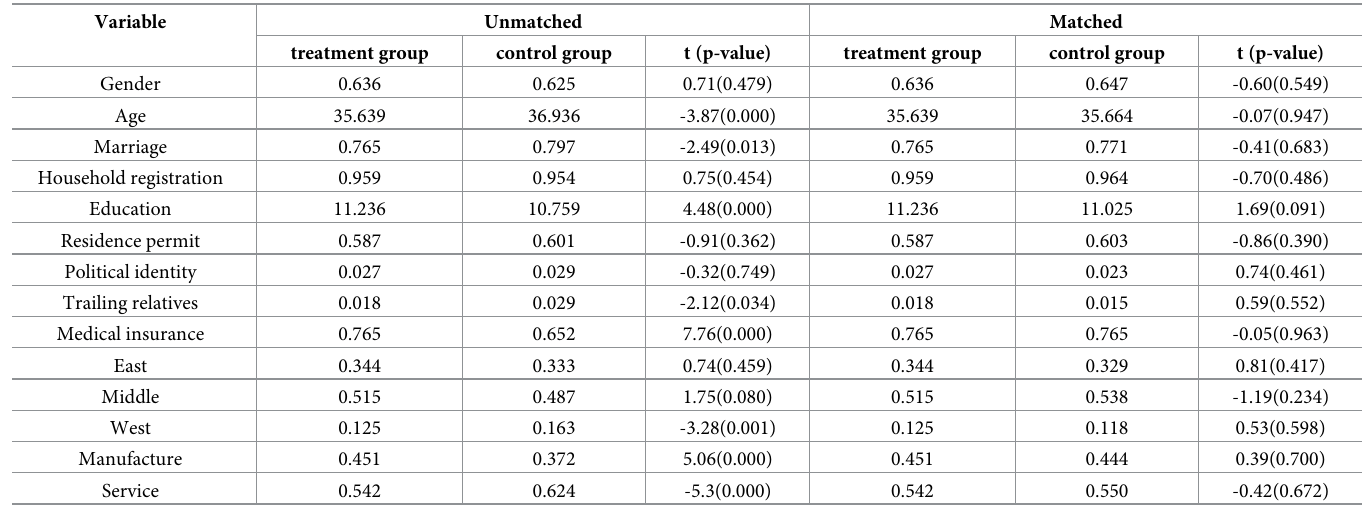
Table 6. Balance test of the main variables.